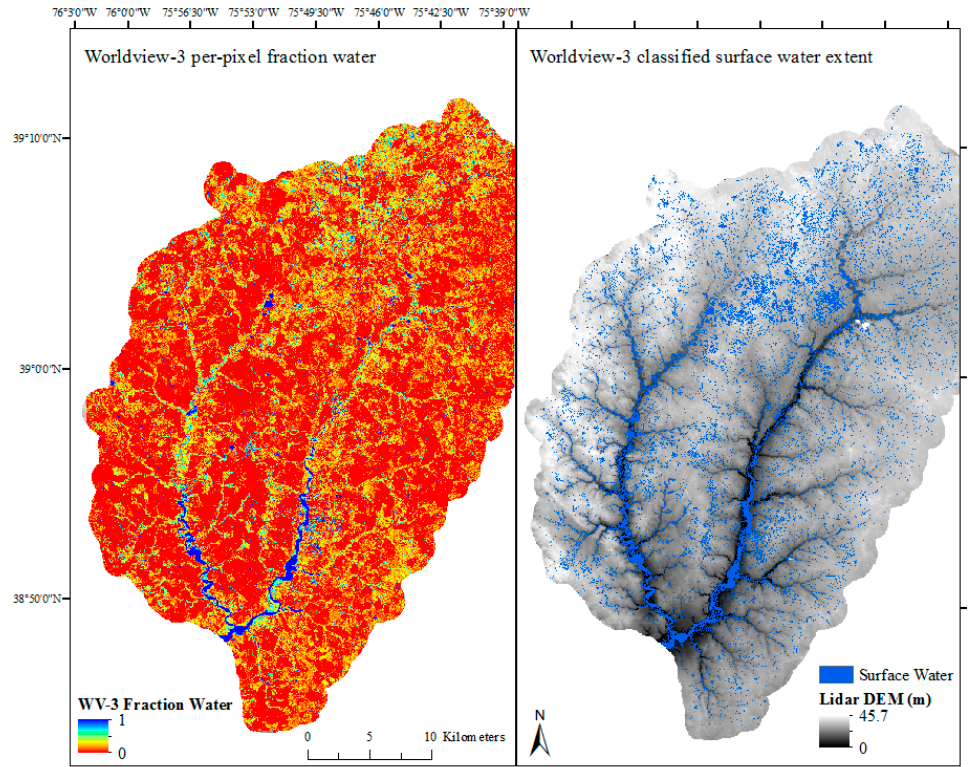
Figure 8. The per-pixel fraction surface water as estimated from Worldview-3 (WV-3) imagery ( left ) over the Upper Choptank Watershed and the final surface water extent, as estimated from Worldview-3 imagery ( right ). DEM: Digital elevation model.